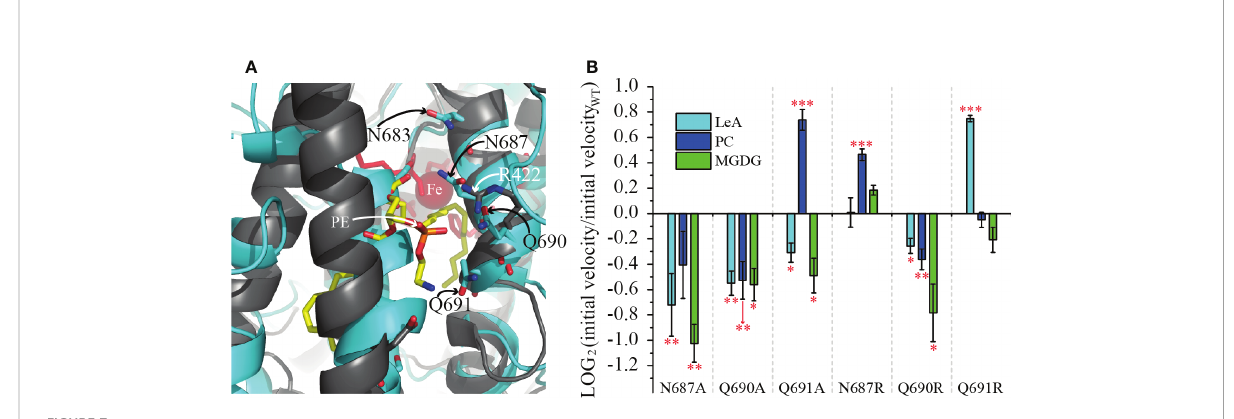
FIGURE 7 Effect of the mutations of the residues N687, Q690 and Q691 on the reaction velocity of LiLOX with different substrates. (A) Superimposition of the modeled structure of LiLOX (black labels) and PaLOX (white labels, PDB accession number: 5IR5). Shown is the entrance of the substrate channel. The modeled structure of LiLOX is depicted as cyan cartoon and sticks. PaLOX is depicted as black cartoon and sticks, the substrate PE in yellow sticks and the iron as red sphere. (B) velocity of LOX reaction from mutant enzyme, relative to the WT enzyme (Supplementary Figure 4). LeA: 18:3 (n-3). PC: 18:3 (n-3)/18:3 (n-3)-PC. MGDG: 18:3 (n-3)/18:3 (n-3)-MGDG. Each bar represents the average velocity of three measurements. Each measurement was performed with an independent enzyme preparation. Statistical analysis was carried out using Student ’ s t-test. Asterisks indicate different signi fi cance levels at ***, P < 0.001, **, P < 0.01 and *, P < 0.1 compared with the